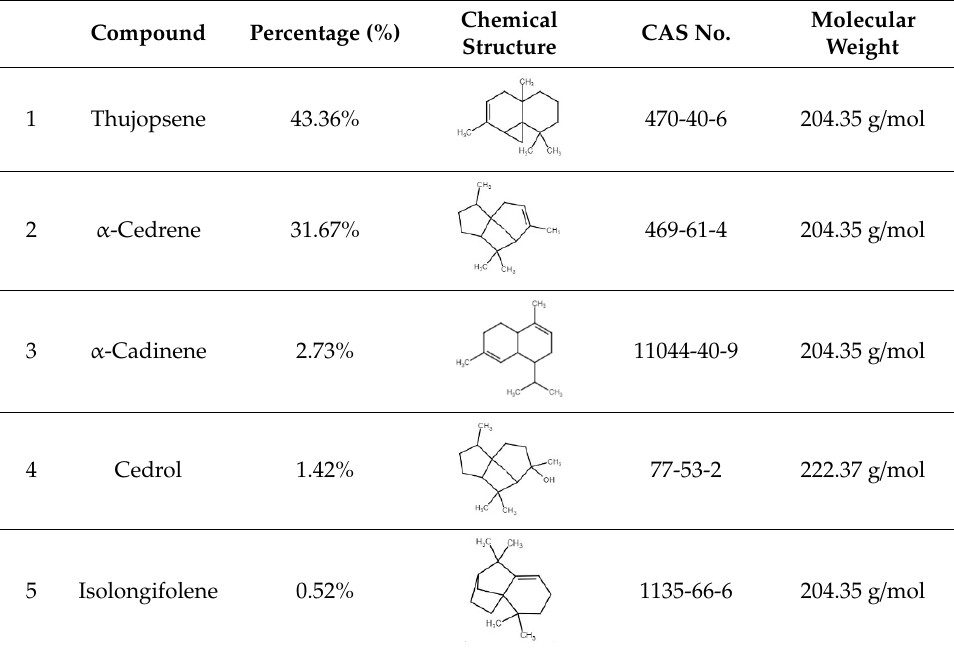
Figure 7. CAt-extract-induced inhibitory effect in the HCC xenograft tumor model by IHC staining. Indicated protein expression in HCC tumor tissues was stained by IHC. ( A ) The level of PCNA, VEGF, VEGFR1, and VEGFR2 protein. ( B ) The level of MMP2 and MMP9 protein. †: A signi fi cant di ff erence between control and treatment, p < 0.05. Table 2. GC-MS analysis of CAt extract.